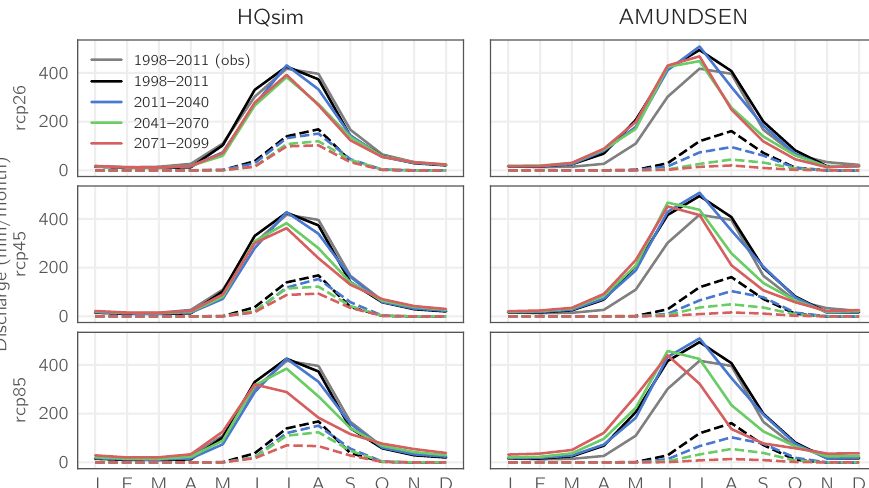
Figure 5. Simulated runoff for HQsim-GEM ( left ) and AMUNDSEN ( right ) under the different emission scenarios RCP 2.6 ( top ), RCP 4.5 ( middle ) and RCP 8.5 ( bottom ). Lines represent monthly multi-model ensemble means for total runoff (solid lines) and ice melt (dashed lines) for three different future climate periods (colored lines). Grey and black lines correspond to observed runoff during the period 1998–2011 (grey) and the corresponding simulation results